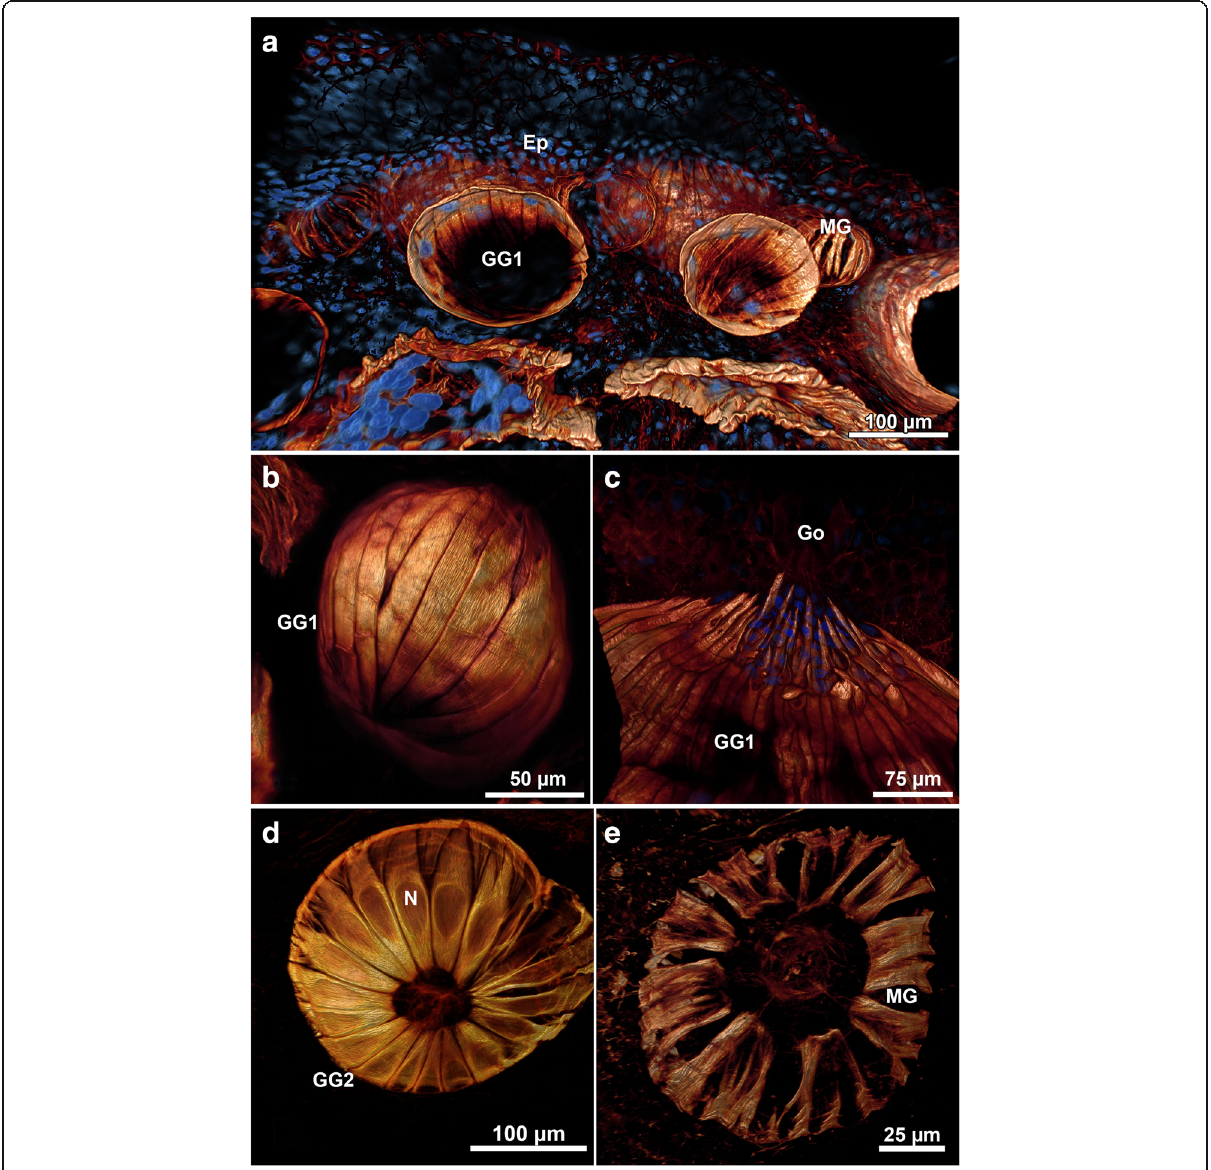
Fig. 3 Muscular system of the cutaneous glands of Tylototriton verrucosus . F-actin staining by AlexaFluor-conjugated phalloidin on vibratome sections and confocal laser scanning microscopy. a Overview of the trunk region showing the epidermis on top as well as the smaller mucus glands and the large granular glands type 1 (GG1). b Detail of a GG1 in the parotoid area. The musculature forms a regular basket around the gland with the fibres orientated in parallel perpendicular to the surface of the skin. c Detail of the opening of a GG1. The myoepithelial cells commonly extend as thin fibres towards the gland opening. d Top view of a granular gland type 2 (GG2) of the tail region showing a similar arrangement of cells as in the first type of granular gland. Note the oval areas of the nuclei regularly arranged close to the gland opening. e Detail of the muscular system of a mucus gland in the tail region, top view similar as in ( d ). The muscular basket of the mucus glands commonly looks less dense than the granular types. Ep, epidermis; Go, gland opening; MG, mucus gland; N,